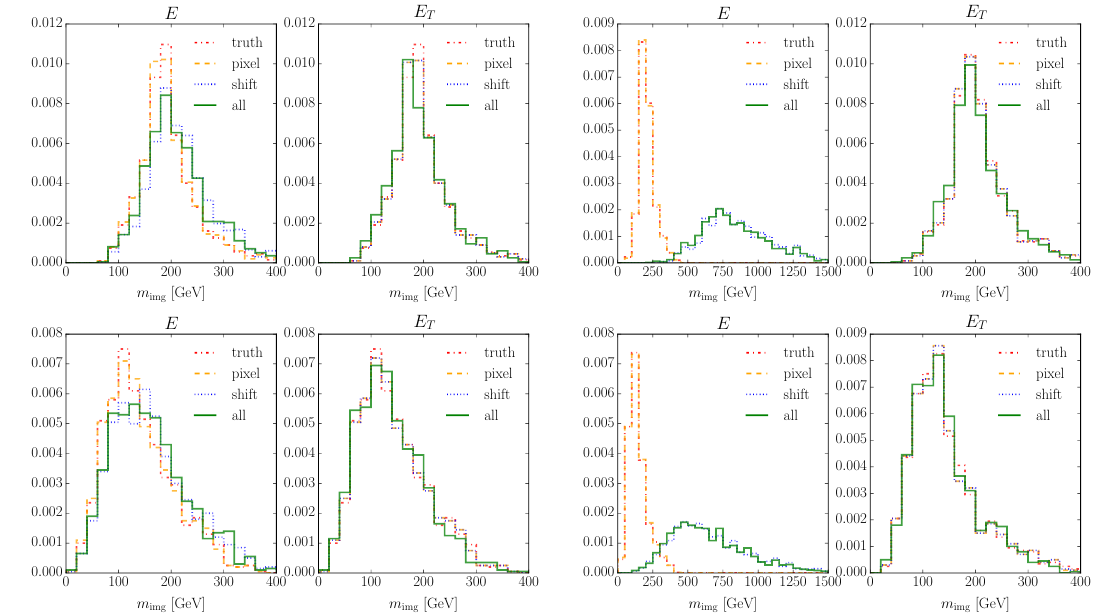
Figure 2 . E(cid:11)ect of the preprocessing on the image mass calculated from E -(left) and E T -images (right) of signal (top) and background(bottom). The right set of plots illustrates the situation for forward jets with (cid:17) > j j